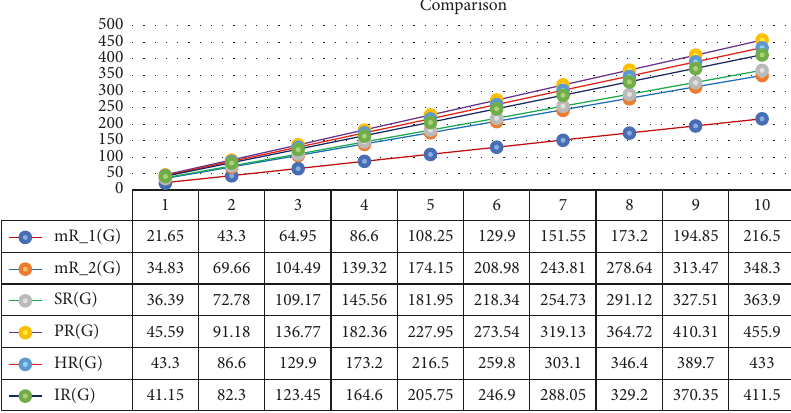
Figure 6: Comparison of m R